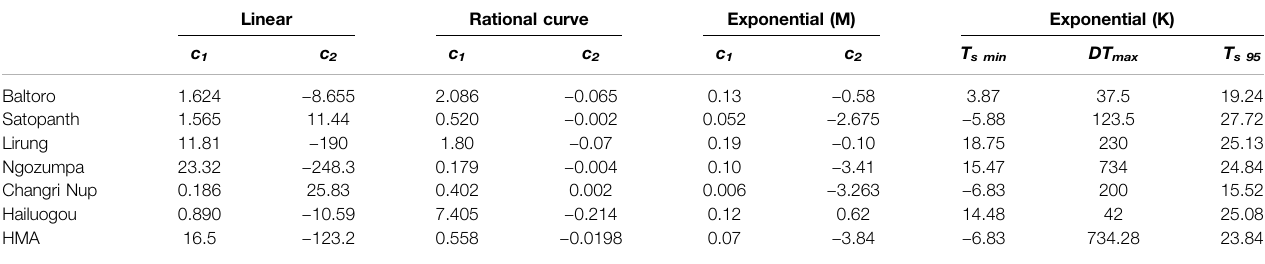
TABLE2| Constantsderivedforeachofthefourformsofdebristhickness/surfacetemperature relationship[linear,rationalcurve,exponential (M)andexponential(K)],forall six glaciers and for the HMA region. Linear Rational curve Exponential